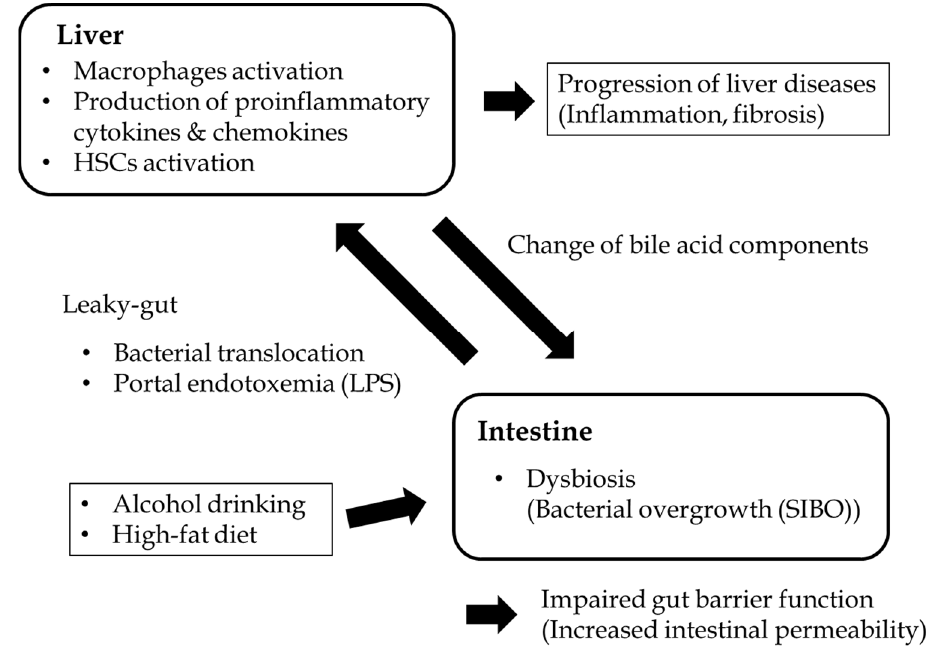
Figure 1. Schema of the interaction between the gut and liver in CLDs. Lifestyle factors such as drinking alcohol and consuming a high-fat diet alter the diversity of the gut microbiota and result in bacterial overgrowth, increasing bacterial translocation including endotoxins (lipopolysaccharides; LPS). LPS can translocate into the portal vein via the disruption of the gut barrier, eventually reaching into the liver as a result of increased intestinal permeability, strongly activating regional liver immune cells, mainly Kupffer cells, which produce proinflammatory cytokines and chemokines. LPS also stimulate the activation of hepatic stellate cells, which play a main role in the progression of liver fibrosis via the production of extracellular matrix proteins such as collagens.